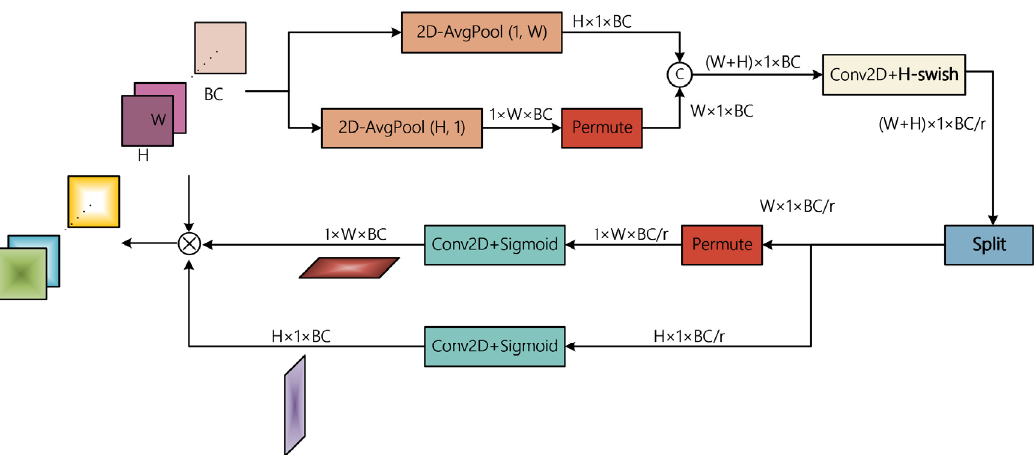
Figure 3. Schematic diagram of spatial–spectral feature refinement based on coordinate attention.